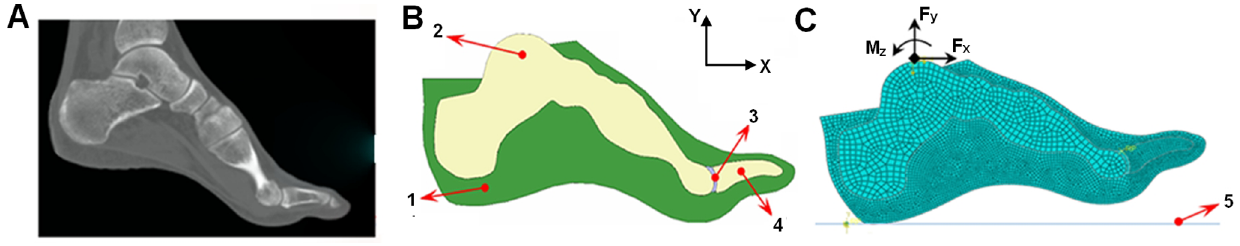
Figure 1. The 2D finite element modelling of the human foot complex. (A) The foot CT image along the first ray. (B) The 2D foot geometric model based on the CT image. (C) The 2D finite element foot model. (1. soft tissue, 2. bone structure except phalanges, 3. cartilage, 4. phalangeal bones, 5. ground surface)